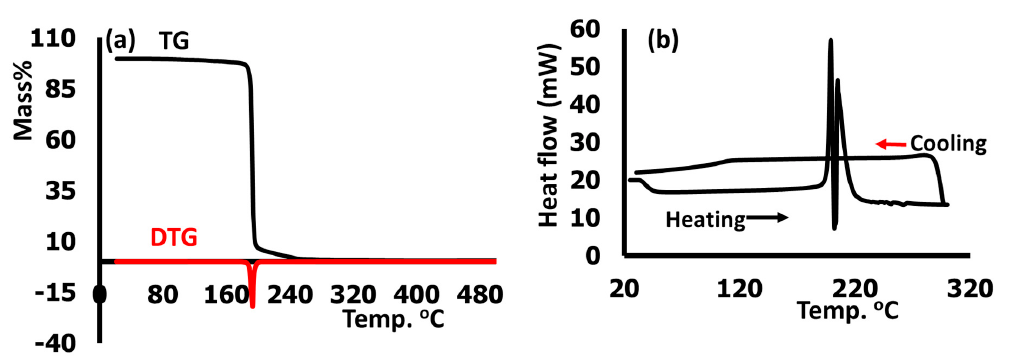
Figure 9. ( a ) TG/DTG and ( b ) DSC diagrams.